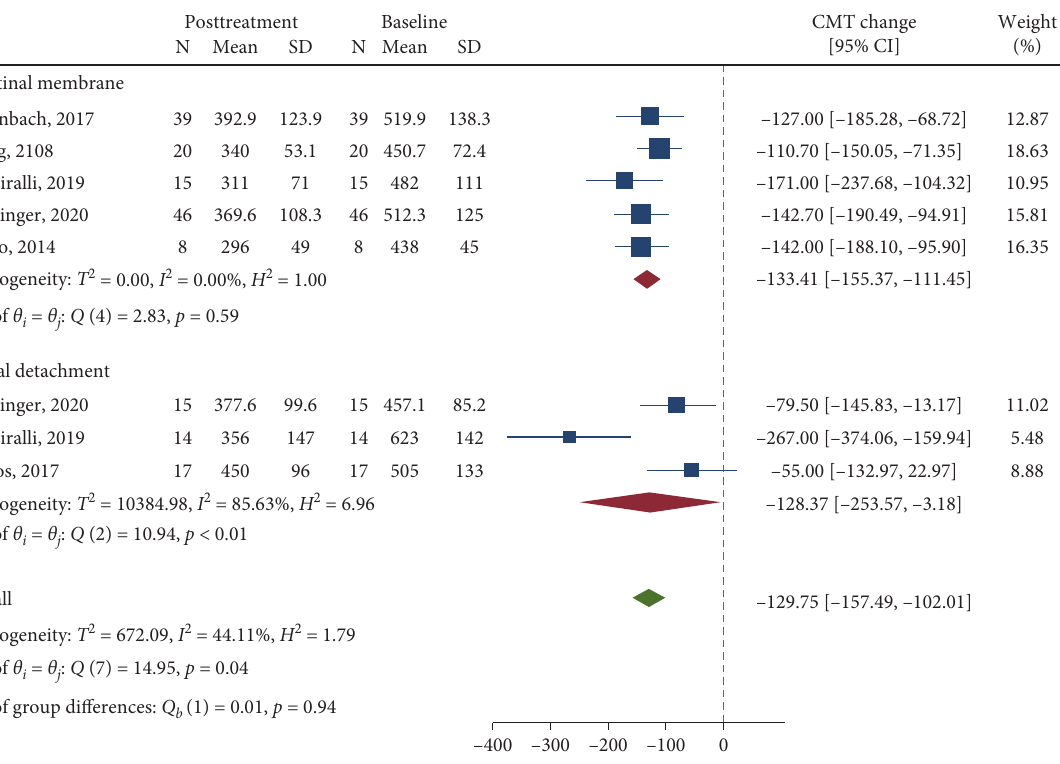
Figure 4: A forest plot showing mean change in central macular thickness considering the last available follow-up after treatment with dexamethasone